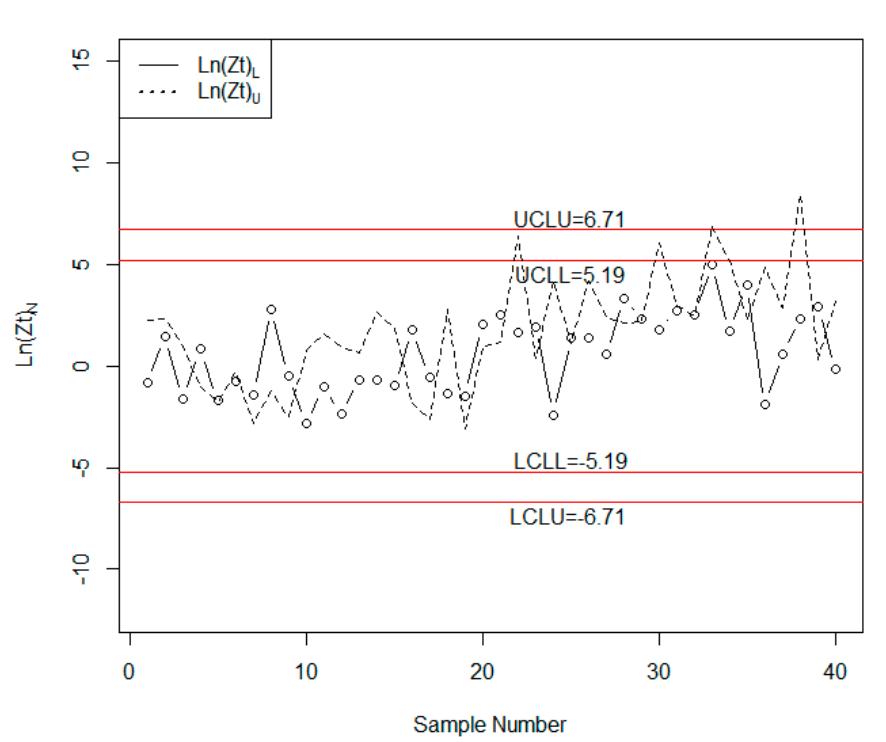
Figure 1. The proposed chart for the simulated data.